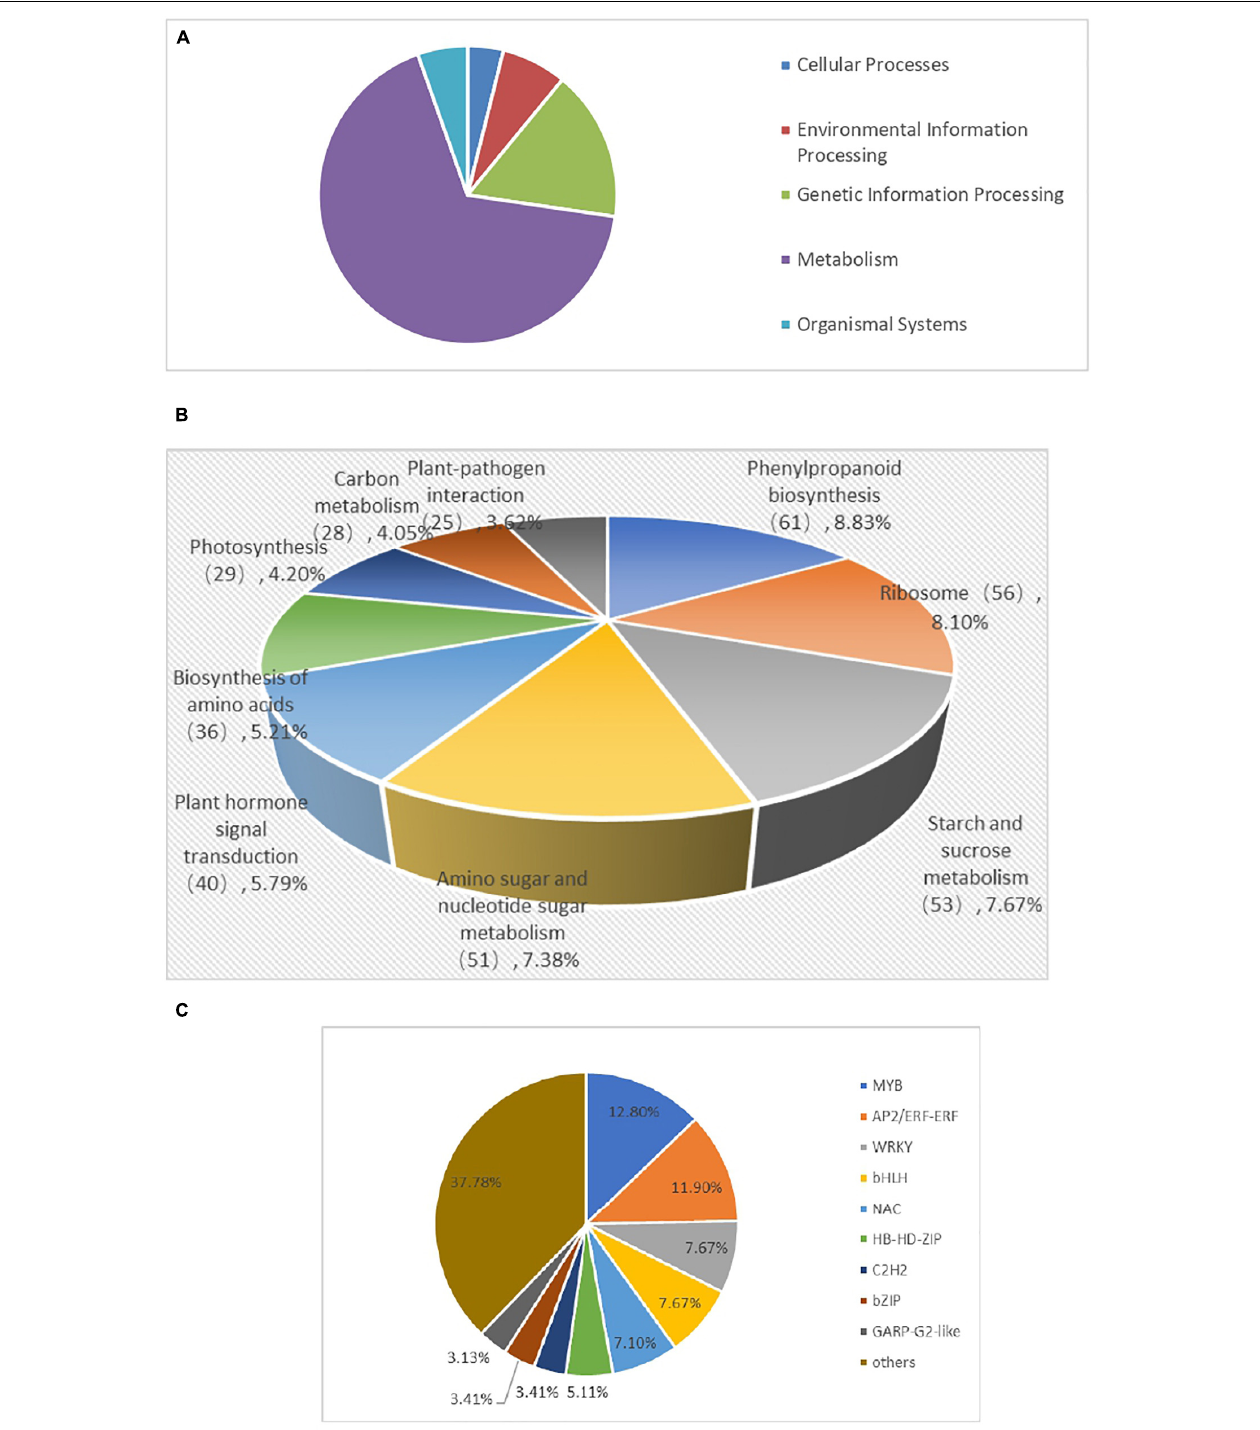
FIGURE 8 | KEGG classification (A) , KEGG enriched pathways (B) , and Distribution of transcription factor gene families expressed (C) of DEGs inBD banana.